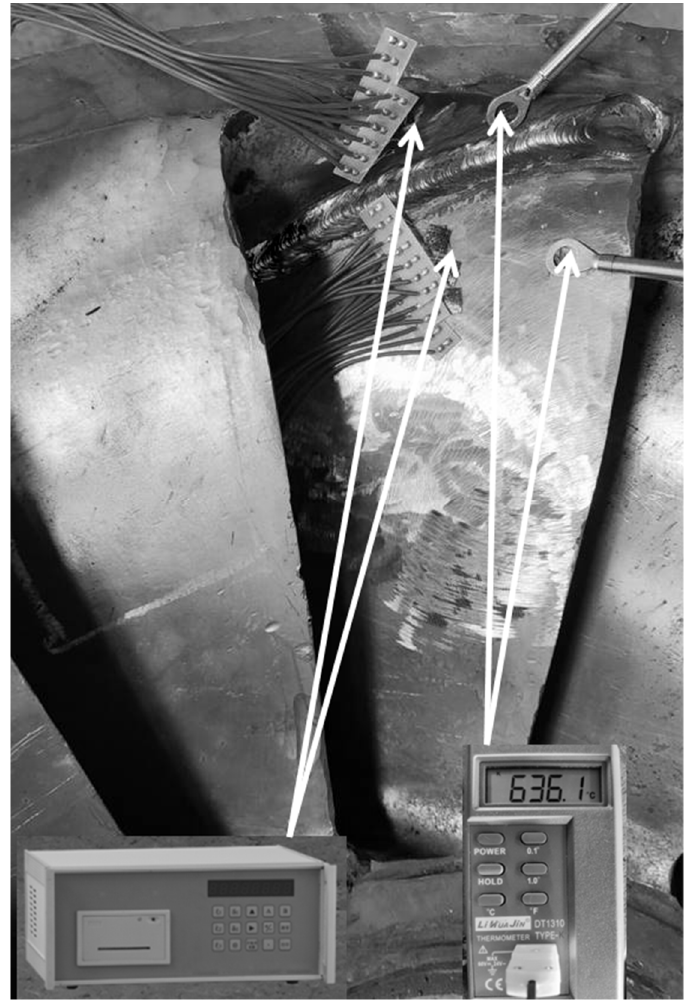
Figure 2. Experimental locations with hole drilling method.